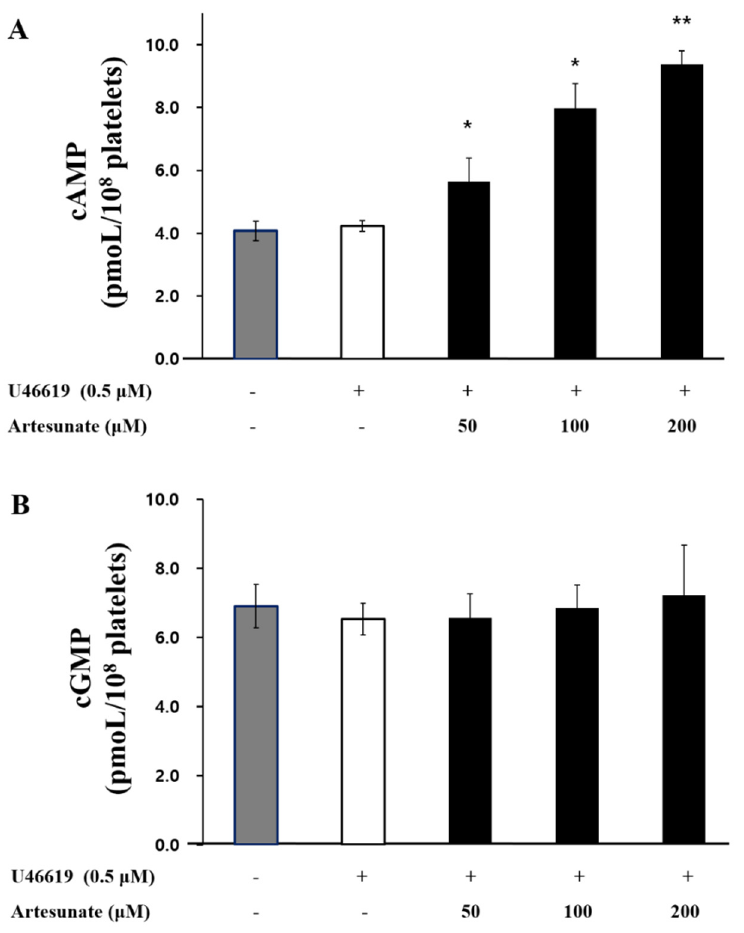
Figure 2. Artesunate’s effect on the production of cyclic nucleotides. ( A ) Effects of artesunate on cAMP production. ( B ) Effects of artesunate on cGMP production. Incubation of the suspended platelets (10 8 cells/mL) occurred at 37 °C while adding different artesunate concentrations, then 2 mM CaCl 2 was added with U46619 (0.5 µM) for stimulation at a duration of 5 min. Termination of the reaction occurred by adding 1 M HCl, and the cGMP/cAMP were measured with a cAMP or cGMP EIA kit. The results are shown as mean ± SD ( n = 4). * p < 0.05, ** p < 0.001 in comparison to the U46619 − induced platelets.